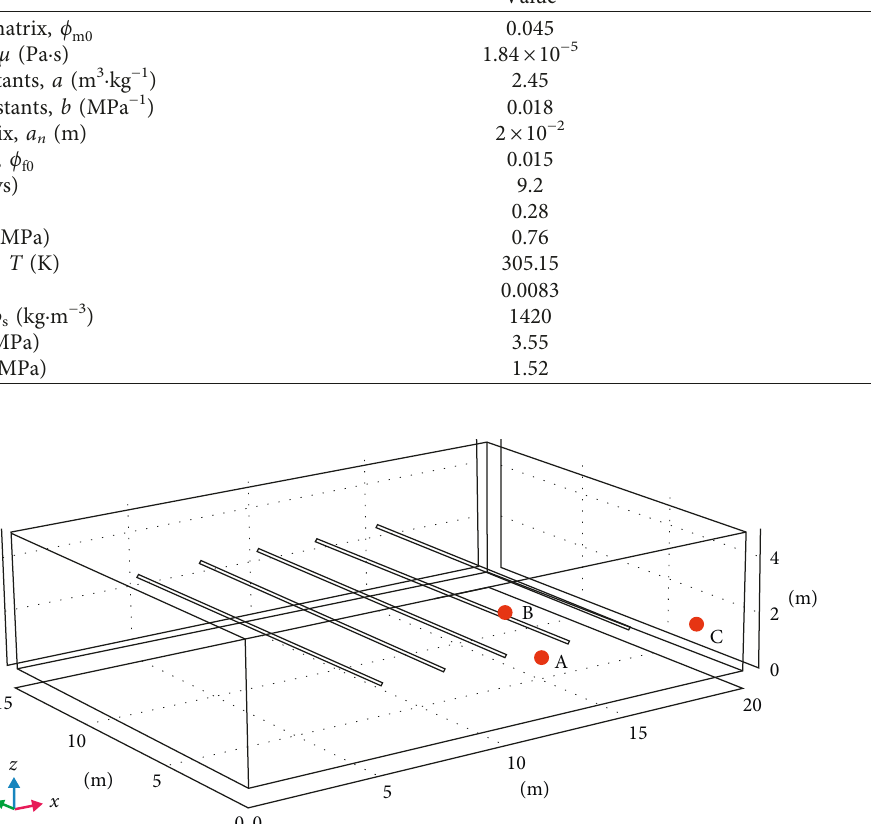
Figure 5: Location of reference points.